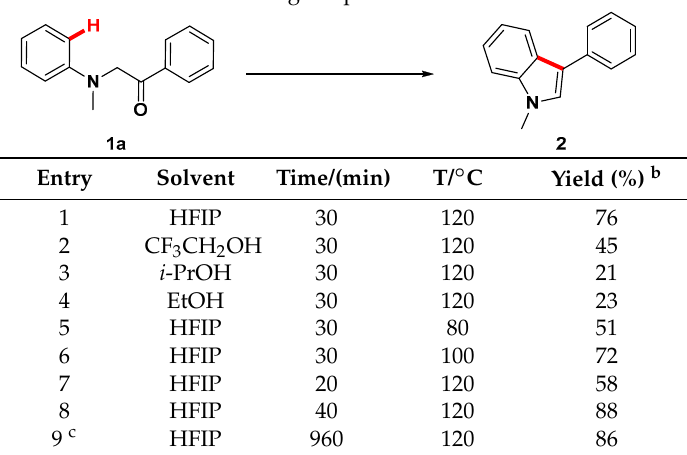
Table 1. Screening of optimal conditions a .